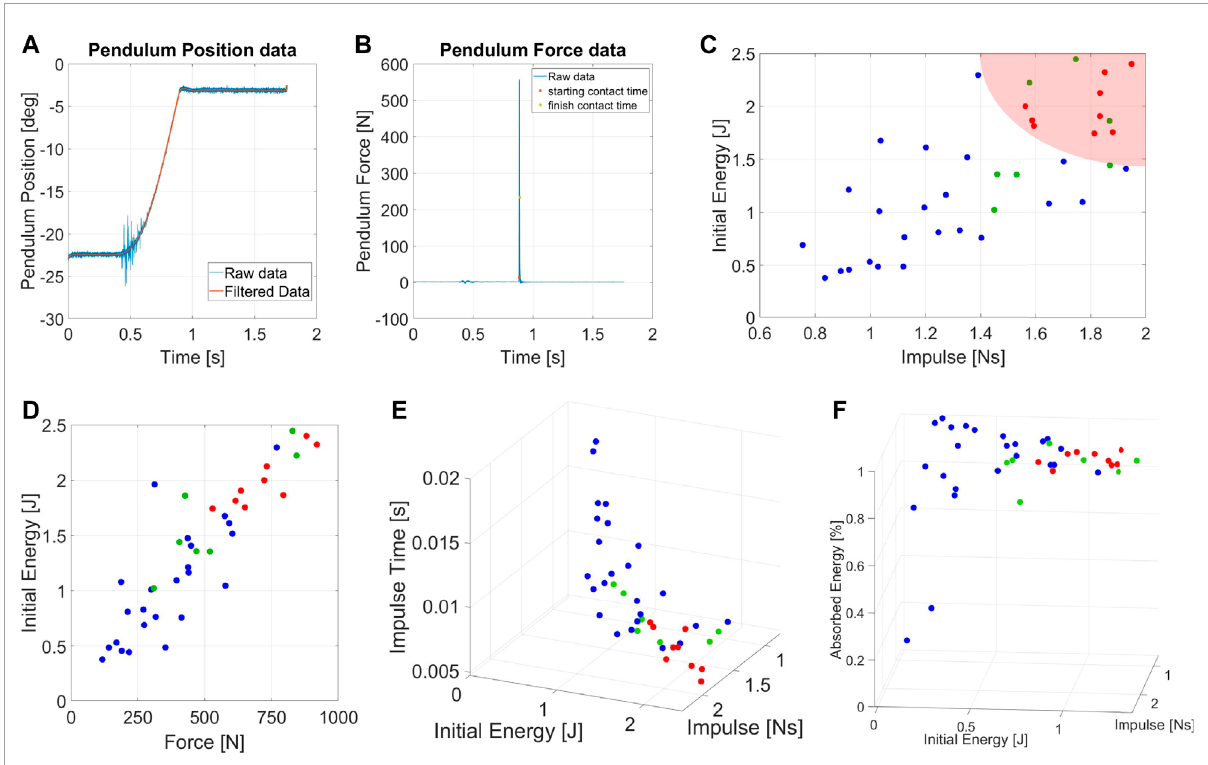
FIGURE 8 Measurement of (A) angular position and (B) force sensor data for the impulsive experiments. (C) Chart of the IRfor the Humanoid robot Alter-Ego. (D) Forces resulting from the impulsive tests applied Alter-Ego. (E) Impulse Time of the experiments varying the initial conditions. (F) Chart of the AEIfor the Humanoid robot Alter-Ego.